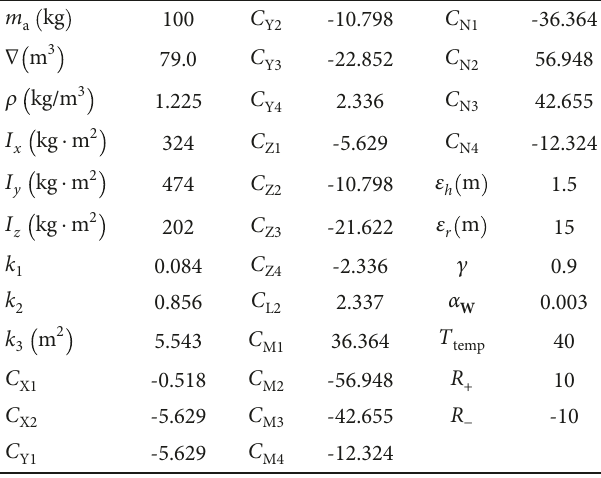
Table 1: Parameters of the airship model and